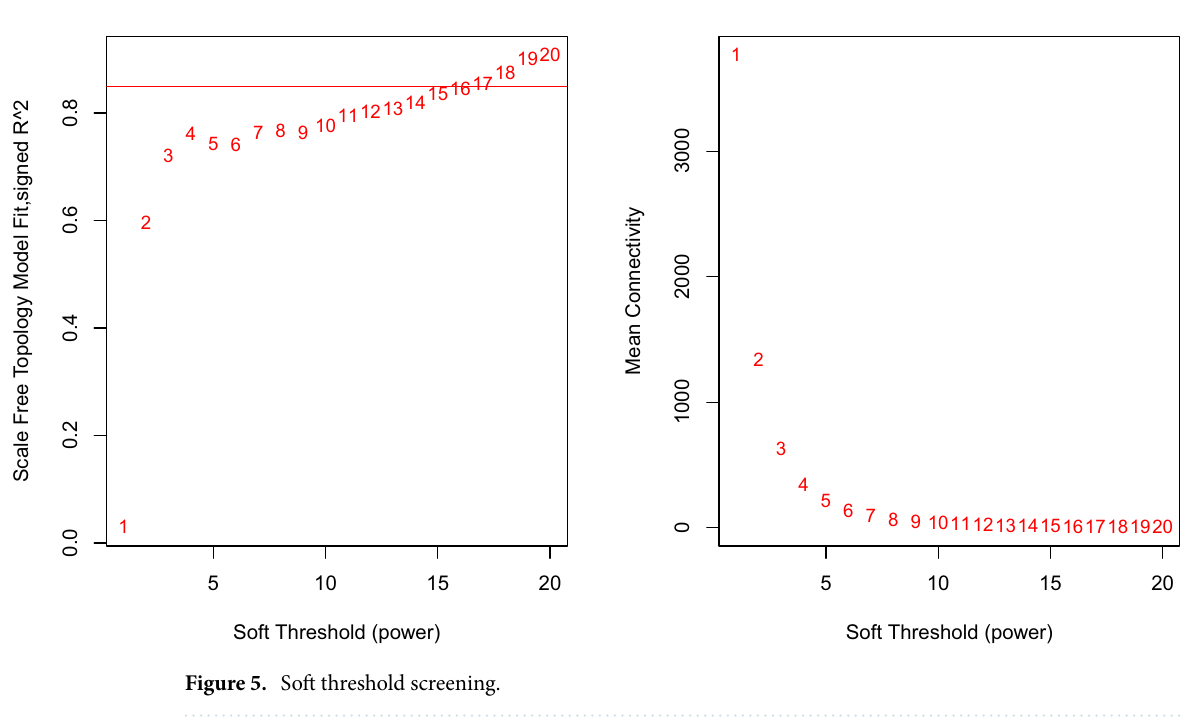
Figure 5. Soft threshold screening.